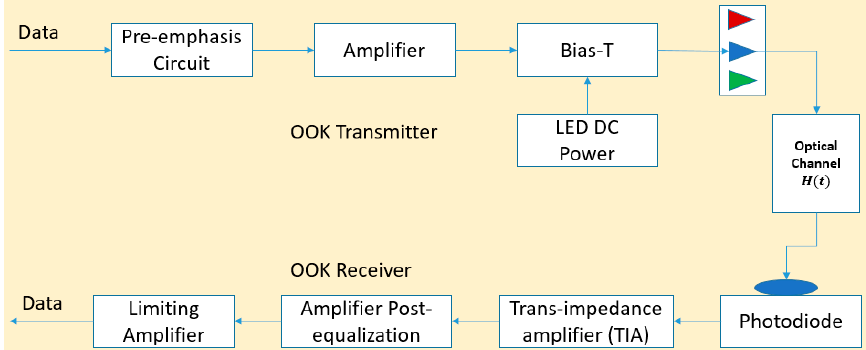
Figure 3. Block diagram of the uplink section. LED: light emitting diode; and OOK: on-off keying.